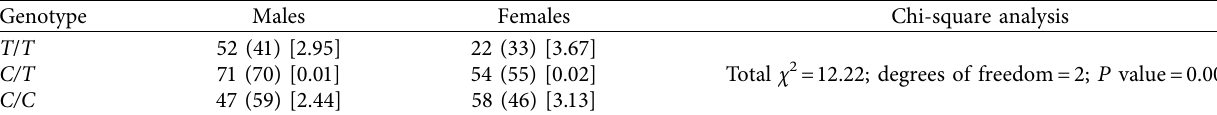
Table 2: Proportion of T/T homozygotes for rs2114724 among male and female patients. Genotype Males Females Chi-square analysis